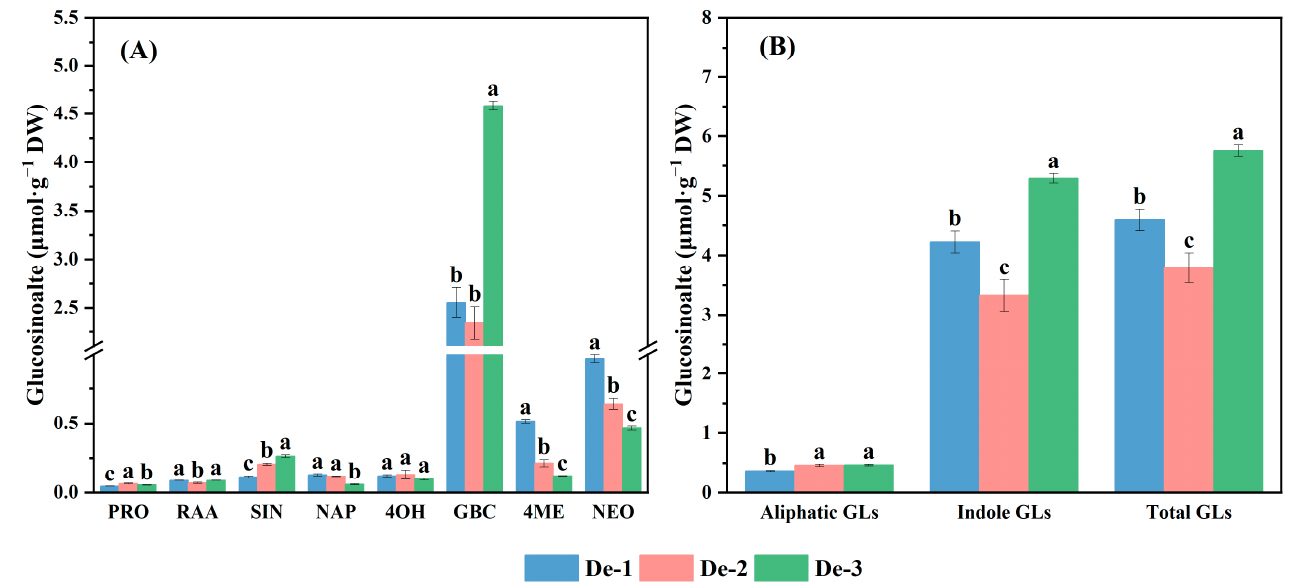
Figure 6. ( A ) Eight individual glucosinolates content in kale grown under different nutrient-solution depths. ( B ) Different sort of glucosinolate content in kale grown under different nutrient-solution depths. Different letters (a–c) marked upon the columns in the figure indicate significant differences between treatments by Duncan’s multiple ( p < 0.05), and vertical bars represent the standard margin of error.